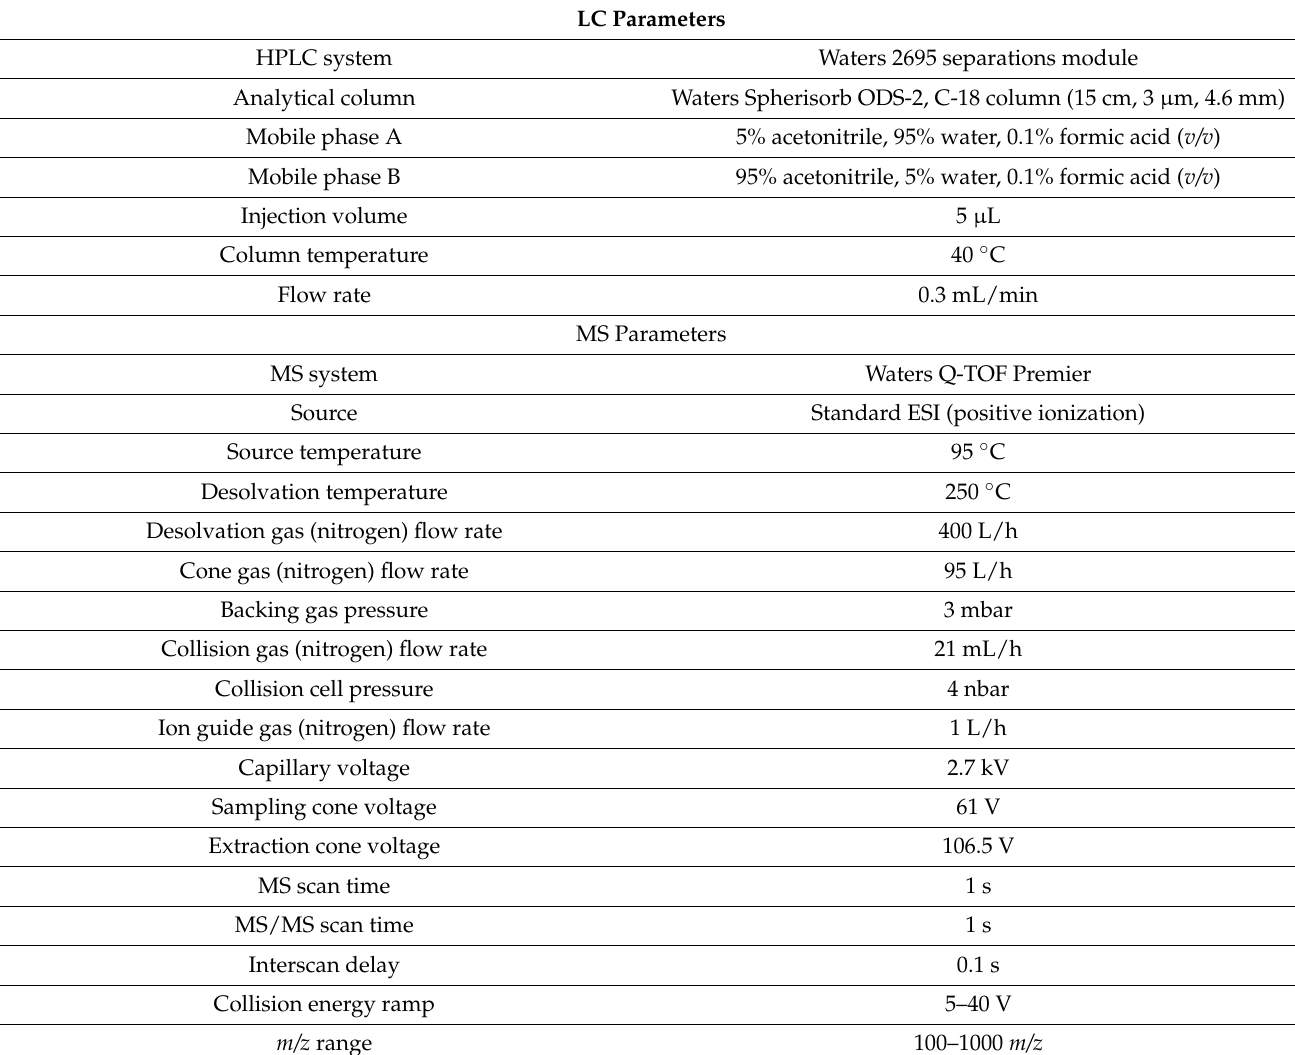
Table 2. The relevant LC and MS parameters for the apparatuses and the utilized